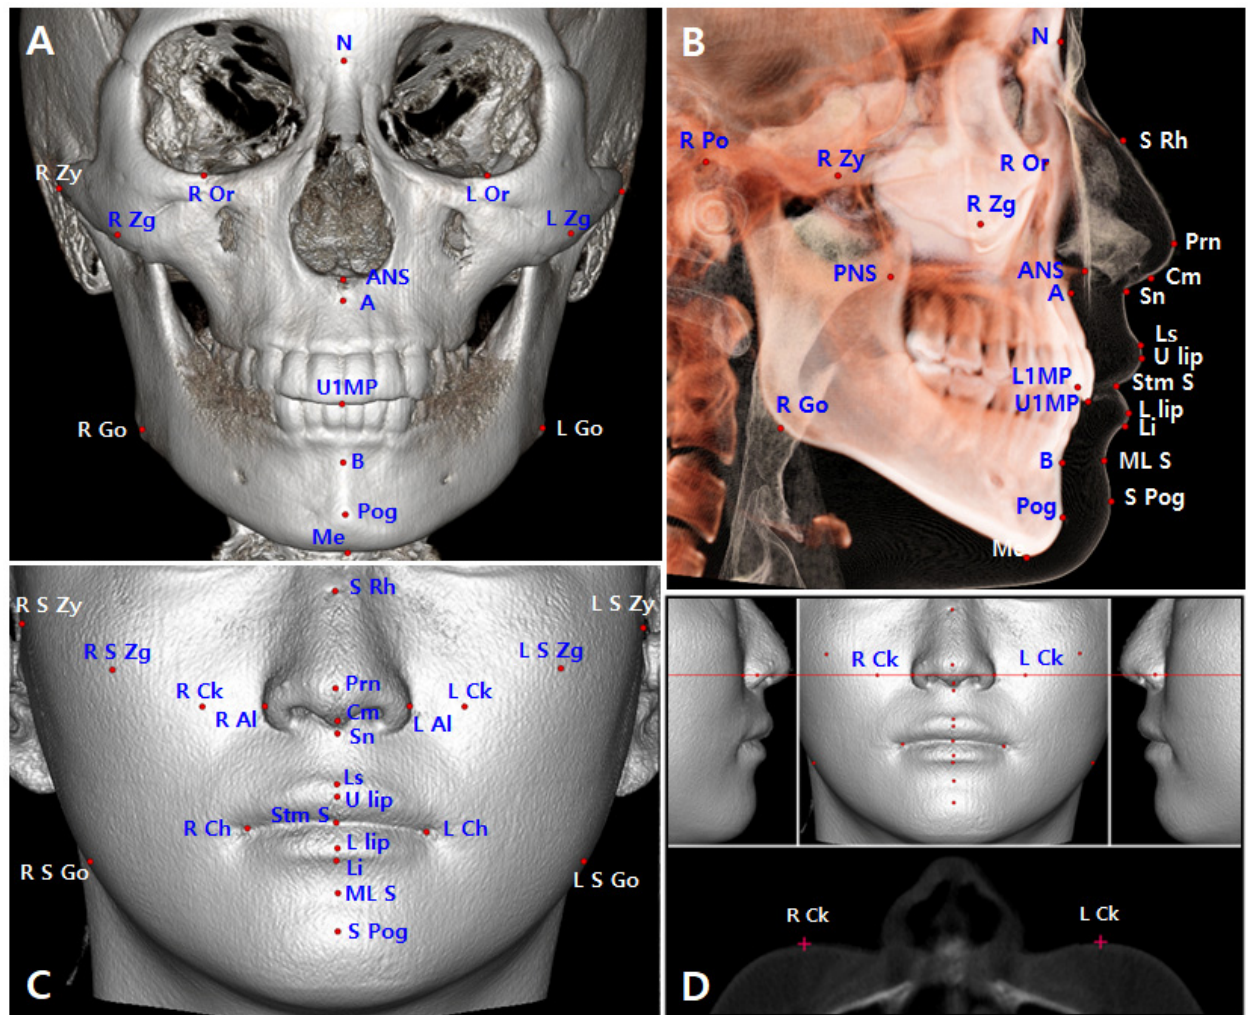
Figure 2. Three-dimensional landmarks. ( A ) Skeletal and dental landmarks in the coronal view. ( B ) Skeletal, dental, and soft tissue landmarks in the sagittal view. ( C ) Soft tissue landmarks in the coronal view. ( D ) Right cheek (R Ck) and left cheek (L Ck) points; the points located at the center of the cheek area and the most anterior point on the axial section of the red line (the red line passes through the median z value of the bilateral alar points and parallel to the x-axis). RL, right and left; N, nasion; Or, orbitale; Po, porion; Zy, zygion; Zg, zygoma; ANS, anterior nasal spine; PNS, posterior nasal spine; A, A point; B, B point; Pog, pogonion; Me, menton; Go, gonion; U1MP, the middle point of the maxillary central incisal tips; L1MP, the middle point of the mandibular central incisal tips; S Rh, soft tissue rhinion; Prn, pronasale; S Zy, soft tissue zygion; S Zg, soft tissue zygoma; Cm, columella; Sn, subnasale; Al, alar; Ck, cheek; Ls, labial superius; U lip, upper lip; Stm S, stomion superior; L lip, lower lip; Li, labial inferius; ML S, mentolabial sulcus; S Pog, soft tissue pogonion; S Go, soft tissue